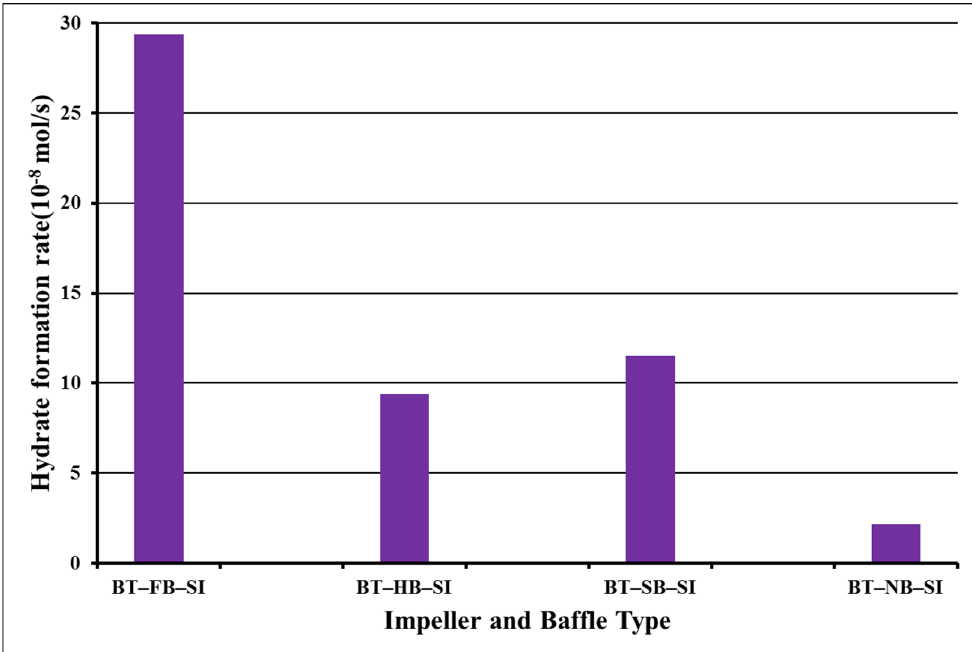
Figure 7. Hydrate formation kinetics values for 10,800 s in dual impellers at starting rotation properties of 2 ◦ C and 42.5 bars. The calculation of fugacity for Equation (6) can be completed using the pressure and fugacity coefficient (by the use of Peng Robinson EOS). Figures 8 and 9 indicate the results of the hydrate formation rate constant ( α K*) with the use of the COAL SEEK method for single and dual-impeller experiments,